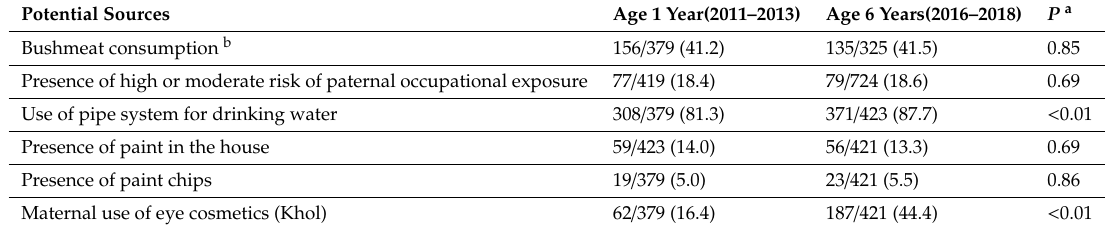
Table 2. Comparisons of sources of lead between age 1 and 6 years in the cohort of children in